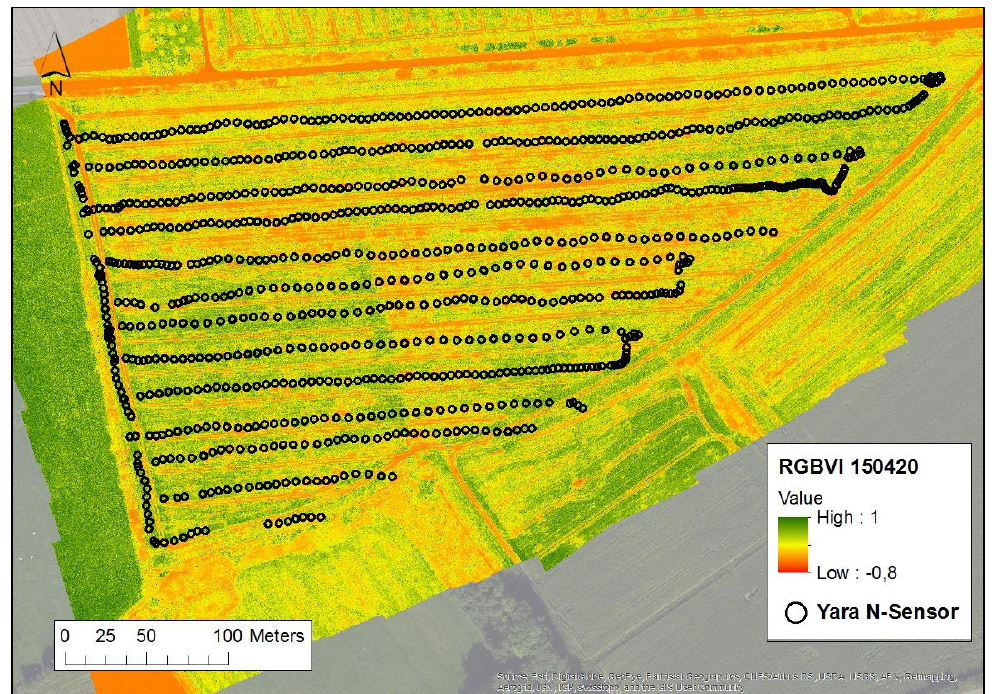
Figure 8. Evaluation of the RGBVI uncal. vs. NDVI cal. for the farmer’s field on April 20 th ,